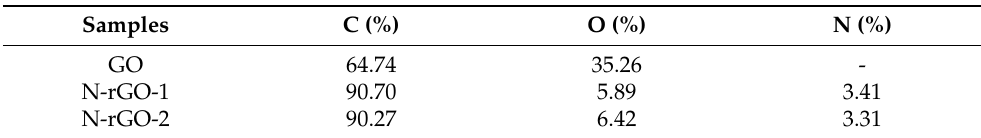
Figure 6. The XPS graph shows ( a ) the survey spectrum of GO and N-rGOs, ( b ) c1s, ( c ) N1s, and ( d ) O1s of N-rGOs. Table 1. Presence of carbon, nitrogen, and oxygen contents in GO and N-rGO samples based on XPS analysis